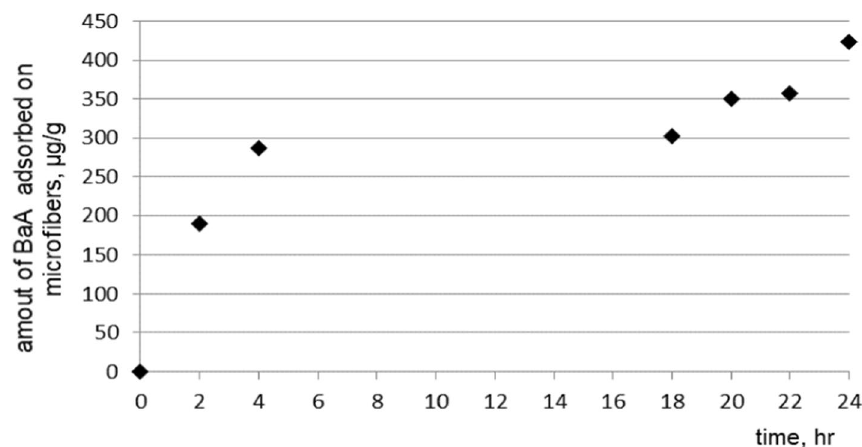
Fig.1 Benzo(a)anthracene (μg/g) adsorbed on microfibers as a function of time